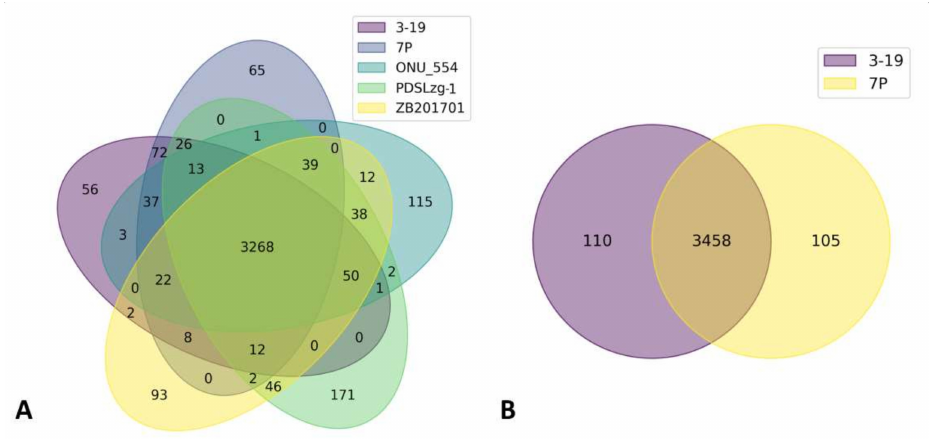
Figure 4. Comparative analysis of orthological set of proteins among five closely related B. pumilus strains ( A ) and two 7P and 3-19 strains ( B